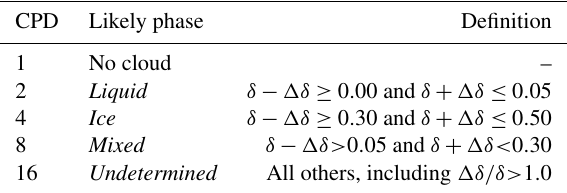
Table 2. Cloud-phase diagnostic.